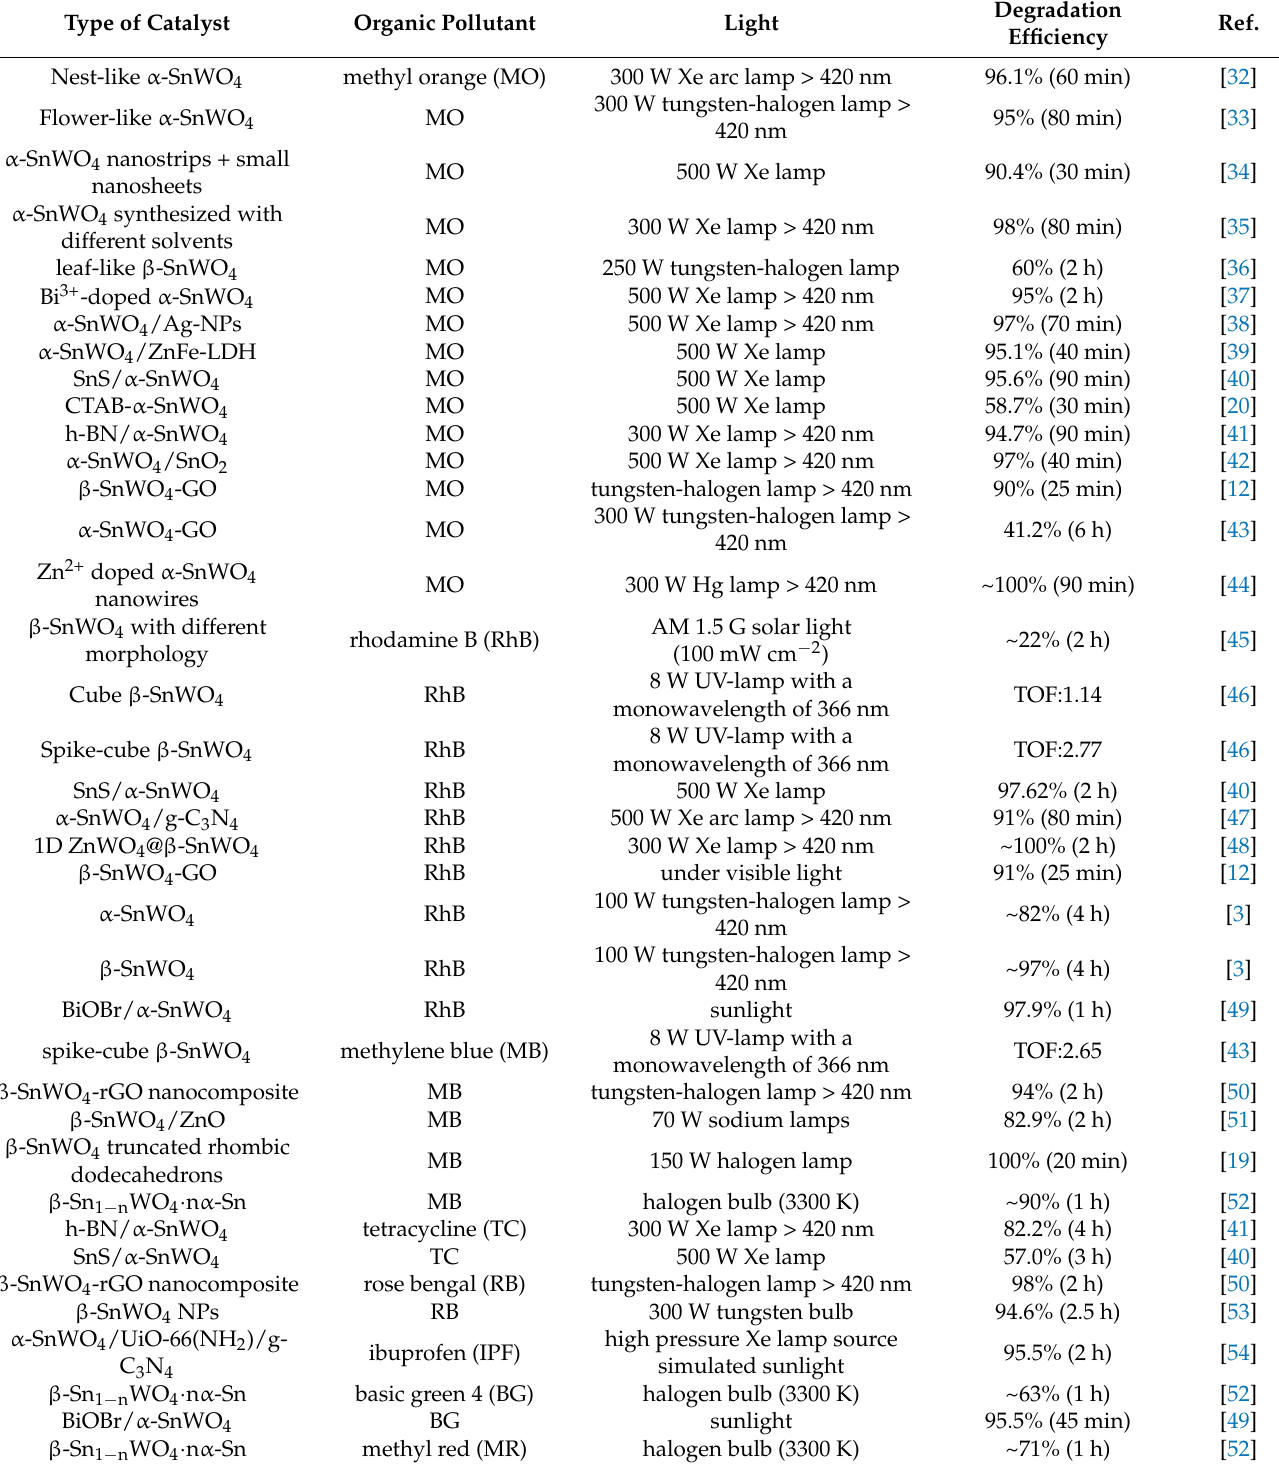
Table 1. Recently reported SnWO 4 -based materials for